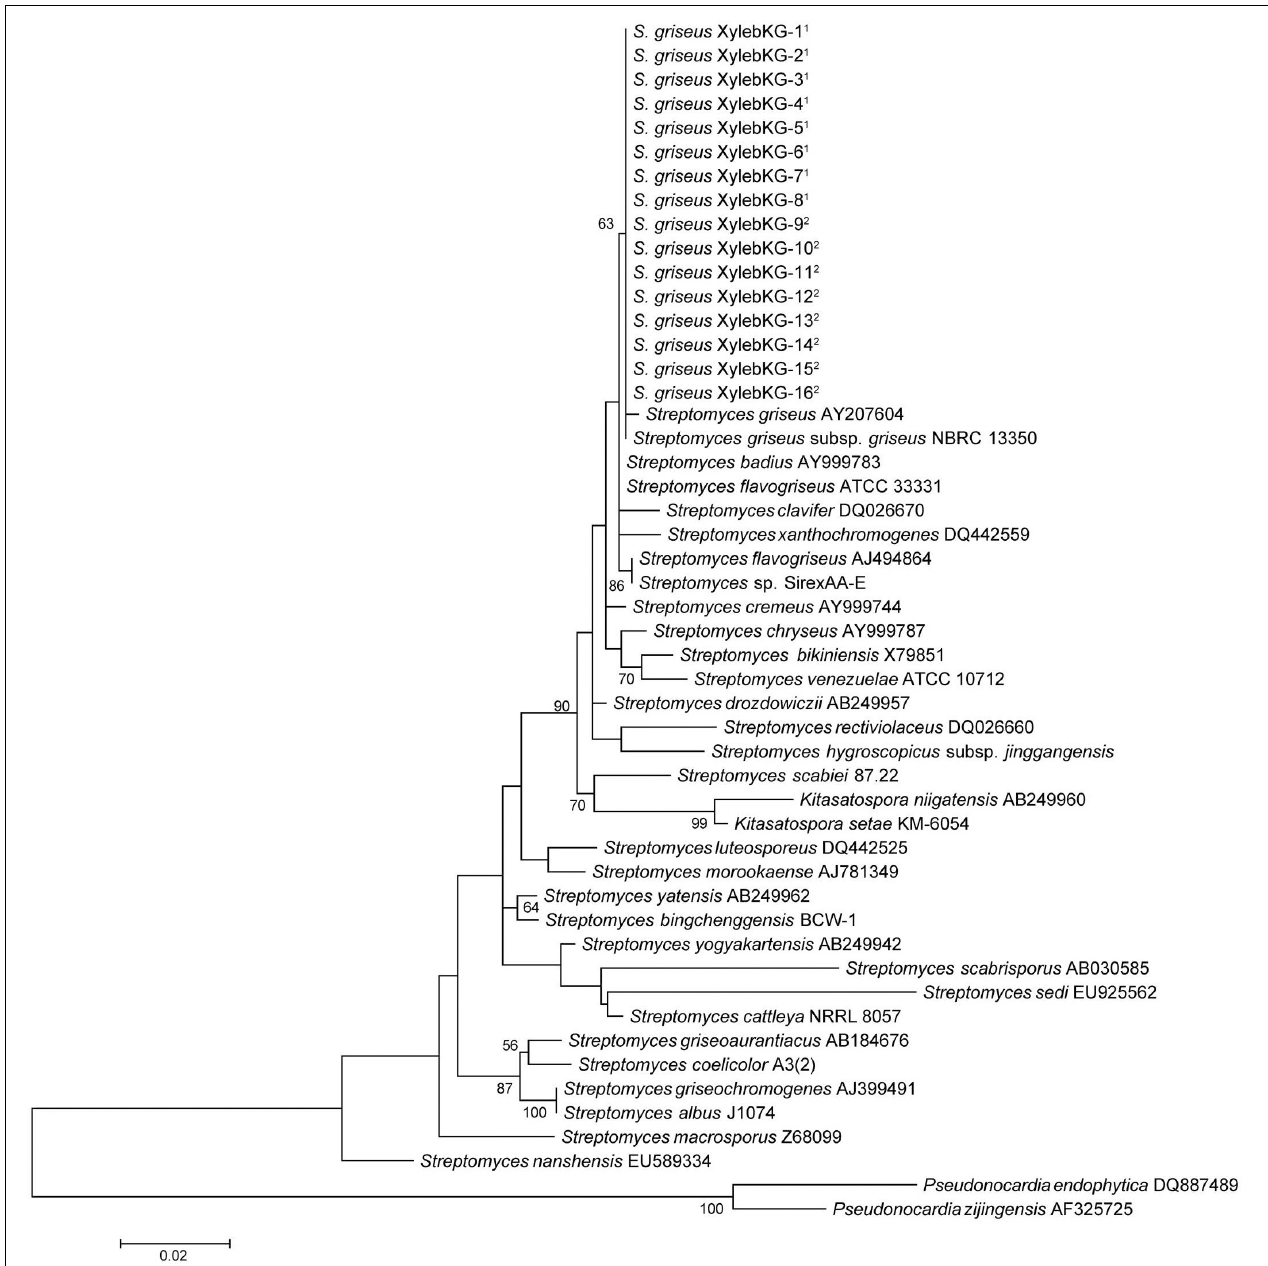
FIGURE 2 | Maximum likelihood 16S phylogeny of the XylebKG-1 clade and its relatives, constructed using MEGA5. Molecular phylogeny based on 1,123 bp of 16S rRNA gene sequence. The Tamura 3-parameter substitution model was used with discrete gamma-distributed rate variation having 5 categories and a proportion of invariable sites, selected by MEGA5 as best fitting the data. The percent node conservation > 50% in 500 bootstrap replicates is indicated, and the scale bar indicates the number of substitutions per site. MEGA5’s initial heuristic tree search was applied using an initial neighbor-joining tree of pairwise distances estimated using the Maximum Composite Likelihood method. 1 - Indicates X. affinis origin. 2 - Indicates X. saxesenii origin. Accession numbers in order from top to bottom of phylogeny: AY207604, AB184347, AY999783, NC_016114, DQ026670, DQ442559, AJ494864, NC_015953, AY999744, AY999787, X79851, NR_102857, AB249957, DQ026660, MF590728, NC_013929, AB249960, NR_112082, DQ442525, AJ781349, AB249962, NC_016582, AB249942, AB030585, EU925562, NC_017586, AB184676, NC_003888, AJ399491, CP004370, Z68099, EU589334, DQ887489, and AF325725.